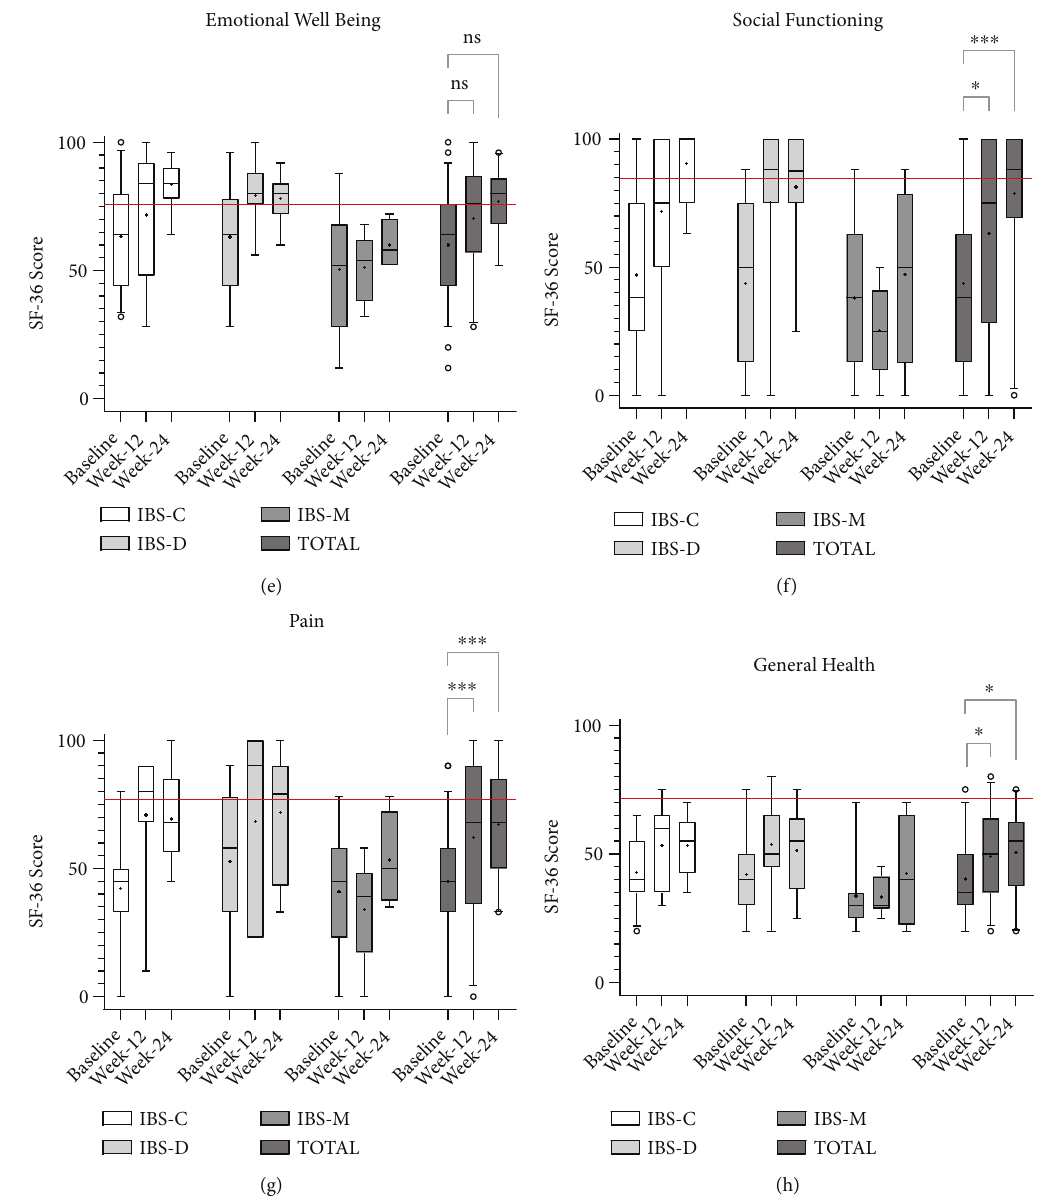
Figure 3: QOL component scores by IBS subtype and total cohort from baseline to week-24 ( N = 59 ). SF-36 QOL component (a) — (h) scores are calculated from speci fi c questions as a total percentage, with scores of 100 being the most positive and scores of zero being the most negative [47]. A 5 – 95 percentile box and whisker plots (a) — (h) were generated in GraphPad Prism 8 with the median and quartiles marked as standard, the mean marked with a ‘ + ’ and outliers marked with a ‘ o ’ . The addition of the red horizontal line is indicative of the average score for a healthy Australian individual ( a = 83 : 6 , b = 79 : 7 , c = 83 : 7 , d = 63 : 8 , e = 75 : 7 , f = 84 : 6 , g = 76 : 9 , and h = 71 : 5 ) [52]. Signi fi cance was graphed as follows; ns =not signi fi cant ( p > 0 : 05 ), * p ≤ 0 : 05 , ** p ≤ 0 : 01 , and *** p ≤ 0 : 001 . Week-52 data was omitted due to low questionnaire return